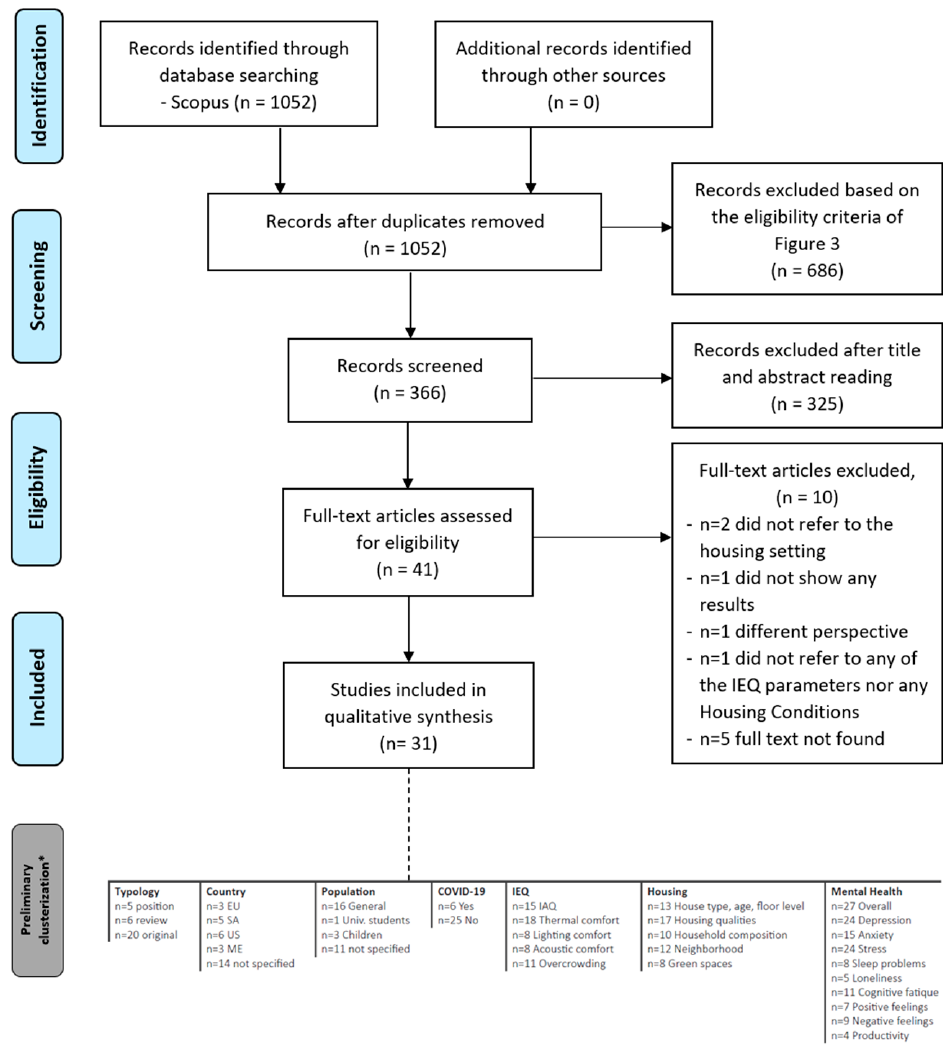
Figure 4. PRISMA flowchart diagram.* Described in Section 2.6.